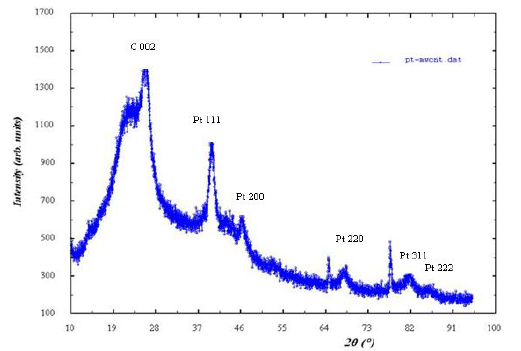
Fig 5. X-ray diffraction patterns of Pt/MWCNT